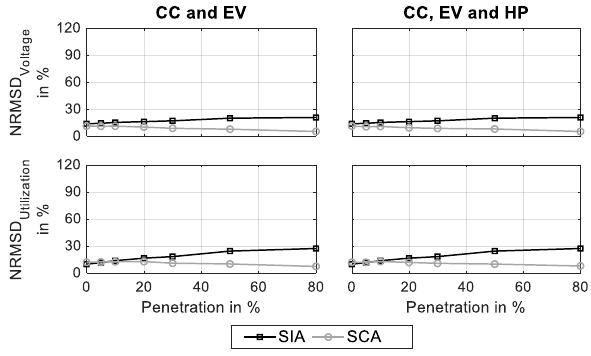
Figure A5. Load approach-induced normalized root mean square deviations (NRMSDs) compared to the TSA in terms of voltage characteristics and thermal utilization considering the urban LV grid located in the city center.